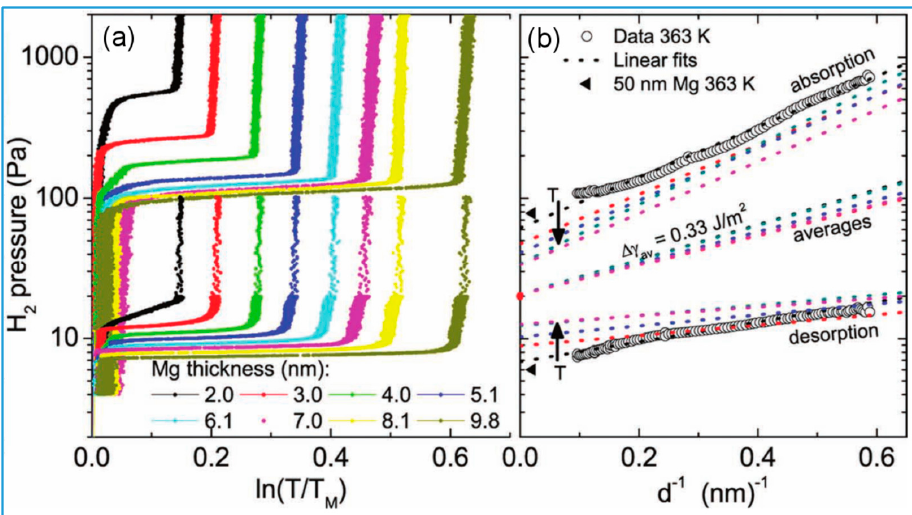
Figure 7. ( a ) Pressure-optical transmission isotherms at 90 °C as a function of the thickness d in a wedge-shaped Mg thin film sandwiched between TiH 2 layers; ( b ) Plateau pressures for absorption and desorption vs. d − 1 at different temperatures in the range 363–473 K. The specific interface free energy can be calculated from the slope of the (logarithmic) averages. The fits are normalized to the average equilibrium pressure at 90 °C for d − 1 = 0 nm − 1 , indicated by the red dot. Adapted with permission from Ref. [49]. Copyright 2011 WILEY-VCH.